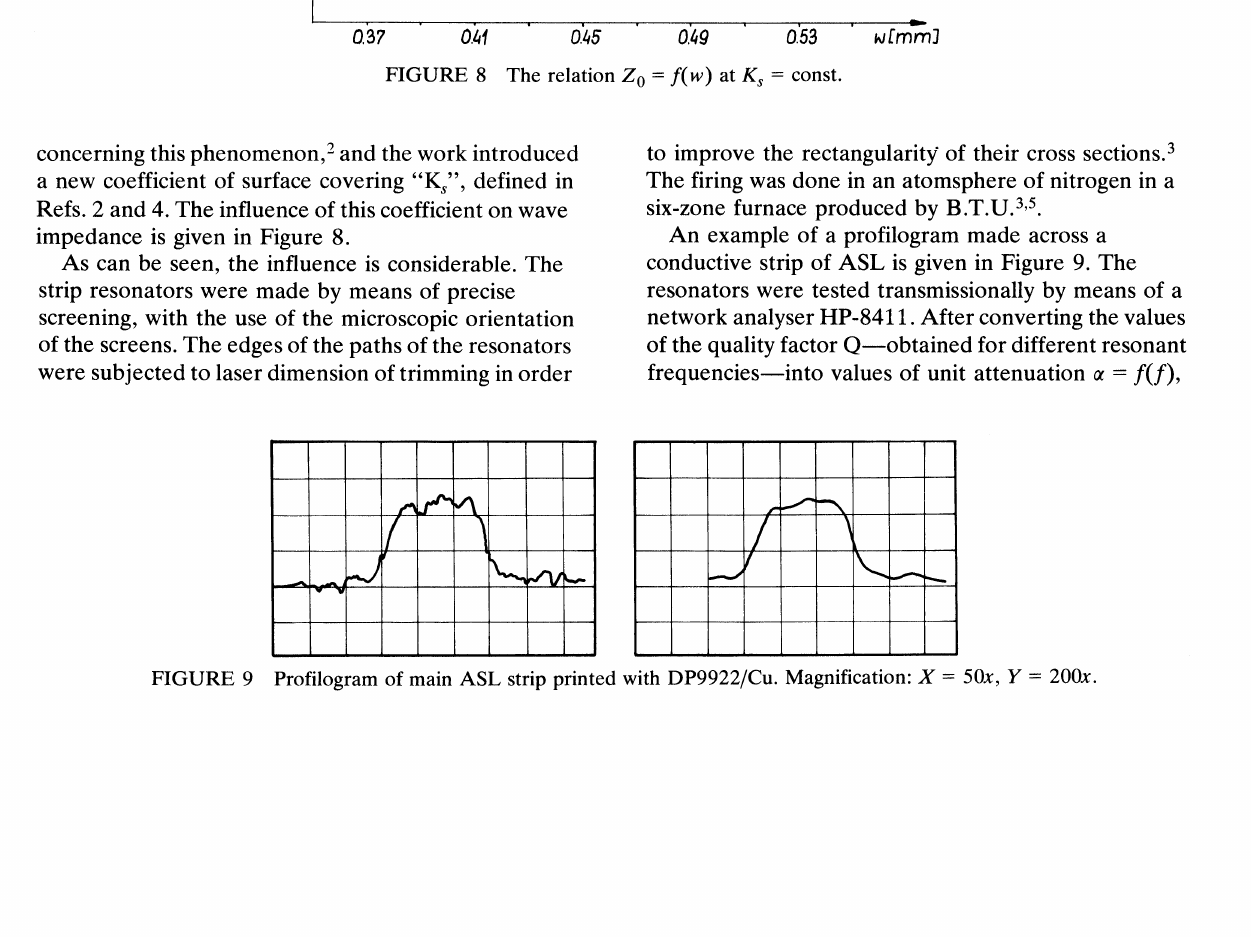
FIGURE 8 The relation Z